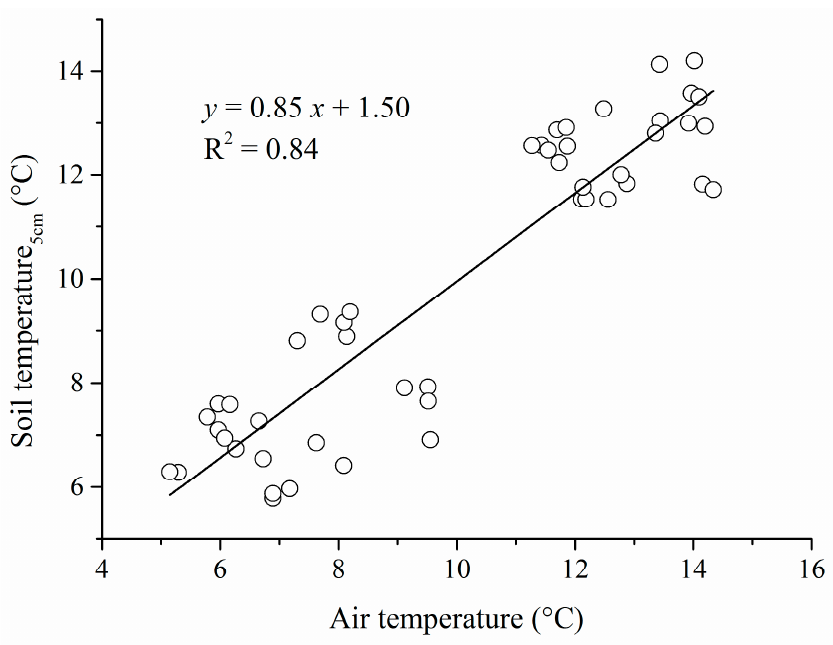
Figure 2. The relationship between mean monthly air temperature and soil temperature at 5 cm depth.